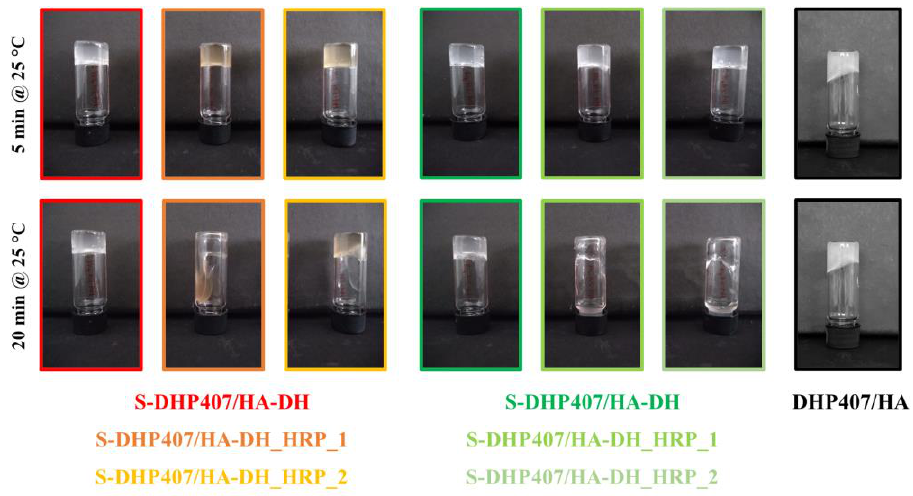
Figure 9. Representative photos of bioartificial S-DHP407/HA-DH and S-DHP407/HA-SH formula- tions with and without H 2 O 2 and HRP showing their sol or gel state upon equilibration at 25 °C for 5 and 20 min. DHP407/HA system was also monitored as control condition.